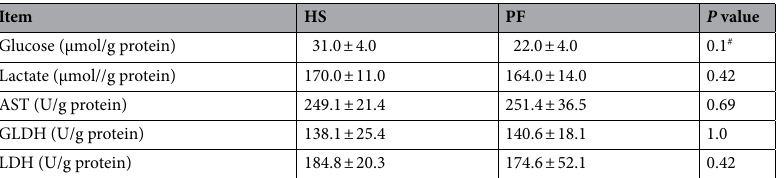
Fig. 1e). At the end of the experimental period, rectal temperature of HS or PF amounted to 40.2 and 38.4 °C, respectively (group P < 0.001; Fig. S1a). The respiration frequency increased from 77 to 95 breaths per min in HS but remained unaltered in PF animals (time x group P < 0.05; Fig. S1b), whilst the heart rate did not change over time or between groups (Fig. S1c). Metabolites, enzyme activities and amino acid composition in jejunal mucosa. The glucose concentration tended to be higher in HS than in PF cows ( P = 0.1), whilst there was no difference in the mucosal lactate concentration (Table 1). The tissue aspartate aminotransferase (AST), glutamate dehydrogenase (GLDH) and lactate dehydrogenase (LDH) enzyme activities were not different among groups. Furthermore, individual, total, ketogenic, glucogenic, essential and non-essential amino acid concentrations did not differ between the mucosa of HS and PF cows (Table 2). Differential proteomic analysis. While a total of 5082 different proteins were identified in samples from all 10 cows (Table S1), only 899 proteins met our selection criteria of being present in at least 3 animals per group. Among these, 81 were tested significantly different between groups, with 59 upregulated and 22 down- regulated mucosal proteins under HS compared to PF conditions (Table S2). The result of the Sparse Partial Least Squares-Discriminant Analysis (sPLS-DA) revealed clear discrimination between proteins of each group and explained 21% of the variation of component 1 and 16% of the variation of component 2 (Fig. 2a). Pro- teins contributing most to the cluster of the HS group were crystallin lambda 1 (CRYL1), Ras-related protein Rab-11B (RAB11B), kreatin 18 (KRT18), and electron transfer flavoprotein subunit beta (ETFB); and of the PF group dolichyl-diphosphooligosaccharide-protein glycosyltransferase subunit 2 (RPN2), calreticulin (CALR), polymeric immunoglobulin receptor (PIGR), alpha-actinin-1 (ACTN1), alpha-actinin-4 (ACTN4), proteasome subunit alpha type-2 (PSMA2) (Fig. 2b). Biological processes. The ClueGO analysis identified 36 GO terms altered in the jejunal mucosa after heat stress (Table 3). These GO terms involve five major biological processes: (1) cellular responses to topologically incorrect protein folding, lysosomal transport and associated protein stabilization; (2) protein kinase inhibitor activity; (3) nucleoside metabolic processes including pyruvate metabolism; (4) regulation of ATPase activity, mitochondrial membrane organization, mitochondrial respiration and the response to reactive oxygen species; and (5) regulation of NIK/NF-κB signaling (Fig. 3, Table S2). More specifically, responses to incorrect protein folding and stabilization processes are characterized by upregulation of the heat shock protein 90 kDa protein protein disulfide-isomerase A3 (PDIA3), but downregulation of the calcium-binding chaperones CANX pro- tein (CANX) and CALR, the transitional endoplasmic reticulum ATPase (VCP), PSMA2, prolyl endopeptidase (PREP) and glucosidase II α subunit (GANAB) in HS cows (Tables 3 and S2). Among proteins assigned to the protein kinase inhibitor group were glutamine t-RNA ligase (QARS) and HSPB1, both higher abundant in HS than PF cows, while nucleophosmin (NPM1) assisting proteins in their transport to the nucleolus and involved in endoribonuclease activity was lower expressed in HS than PF animals. The complexity of nucleoside metabolism includes pyruvate metabolism, the latter involving the glycolytic enzymes glyceraldehyde-3-phosphate dehydrogenase (GAPDH), fructose-bisphosphate aldolase B (ALDOB), aldehyde dehydrogenase 18 family member A1 (ALDH18A1), which were higher expressed in HS than PF cows. By contrast, the glycolytic enolase 1 (ENO1), a subunit of the pyruvate-dehydrogenase complex, dihydrolipoyl dehydrogenase (DLD), and adenosine deaminase (ADA) were lower abundant, whereas transaldolase (TALDO1), a key enzyme of the pentose phosphate pathway was higher abundant in HS than PF cows. For mitochondrial respiration and ATPase activity controlling oxidative phosphorylation, we found ATP synthase subunit alpha (ATP5A1), ATP synthase F(0) complex subunit B1 (ATP5F1), ADP/ATP translocase 3 (SLC25A6), NAD(P) transhydrogenase (NNT), and ETFB higher abundant in HS cows. Moreover, the mitochondrial superoxide dismutase 2 (SOD2) and peroxiredoxin-1 (PRDX1) detoxifying reactive oxygen species in the mitochondria were higher expressed, whilst cytosolic catalase was lower abundant in HS than PF animals. Among proteins positively regulating NIK/NF-κB signaling, we found α-actinin-4 (ACTN4) and CALR lower abundant, whereas 40S ribosomal protein S3 (RPS3) was higher abundant in HS compared to PF animals.